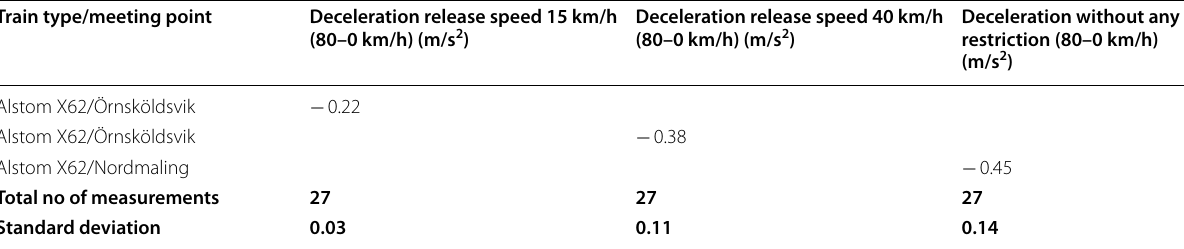
Table 8 Deceleration measurements for three types of target points Train type/meeting